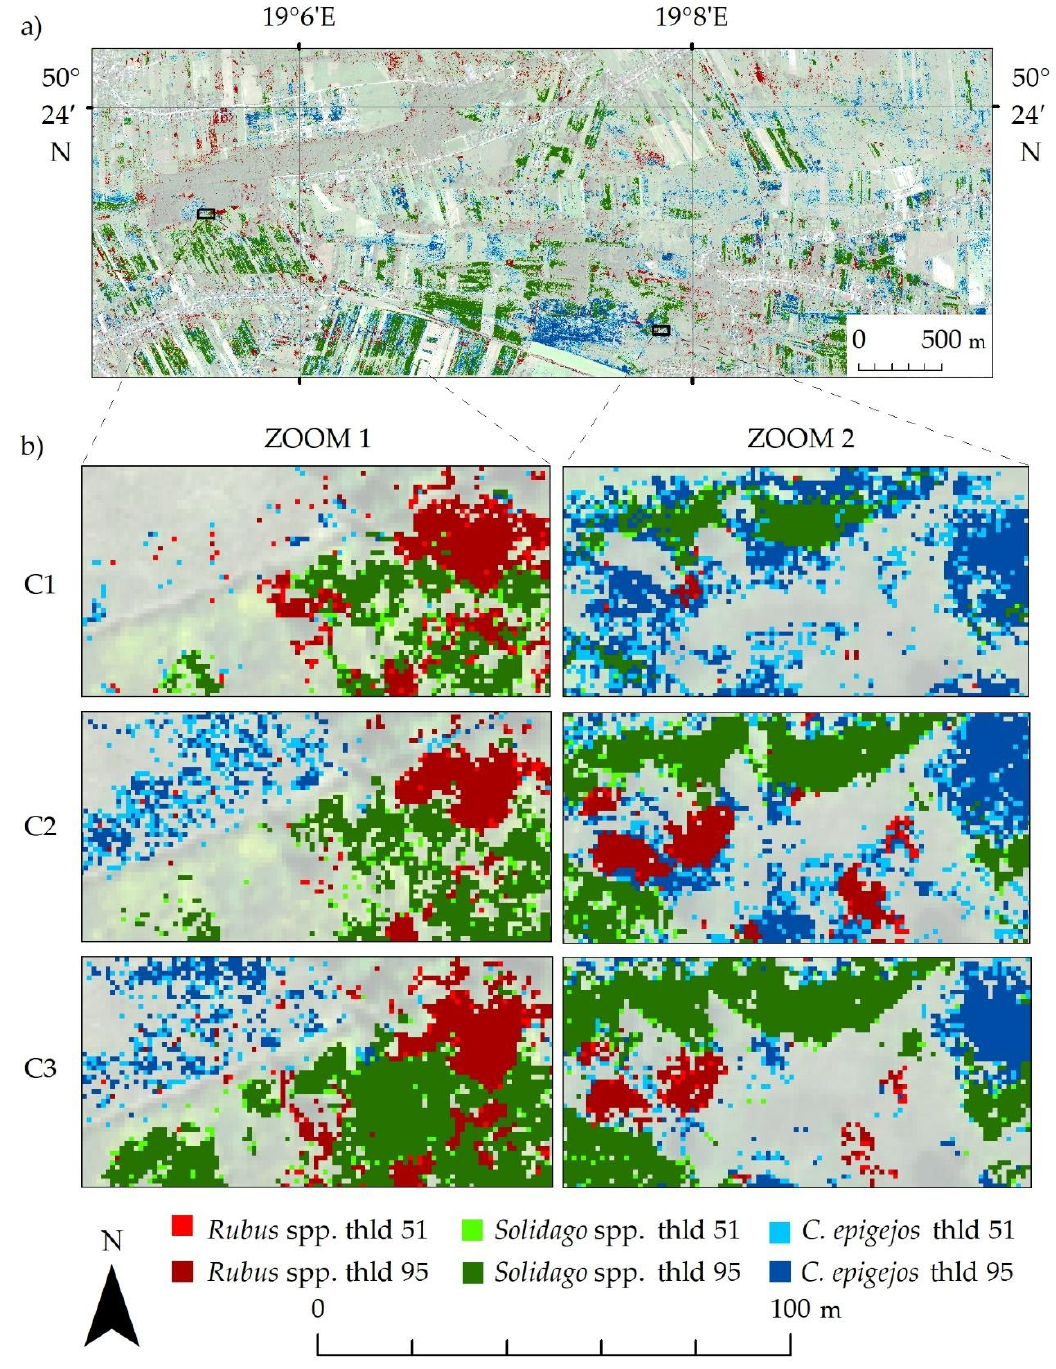
Figure 8. ( a ) Thresholded map for second campaign (C2); ( b ) zooms for each campaign. The spatial distribution of invasive and expansive plants identified in the images for three campaigns is similar. The smallest differences between the analyzed campaigns were visible for the Rubus spp. class. This species reproduces mainly by underground rhizomes and stolons, which results in increased compactness and density clumps identified. On the other hand, Calamagrostis epigejos and Solidago spp. spread quickly in the study area through generative and vegetative reproduction. In the first campaign, individual pixels of these species are visible, which in subsequent campaigns grow into large and compact patches identified by the algorithm with greater frequency. Considering the visual